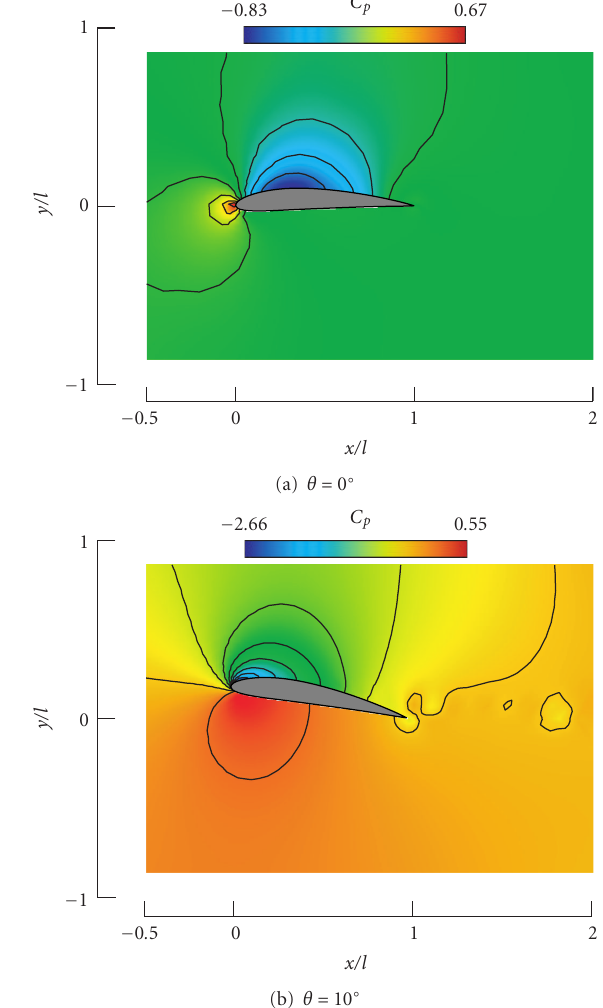
Figure 10: Distribution of pressure coe ffi cient.